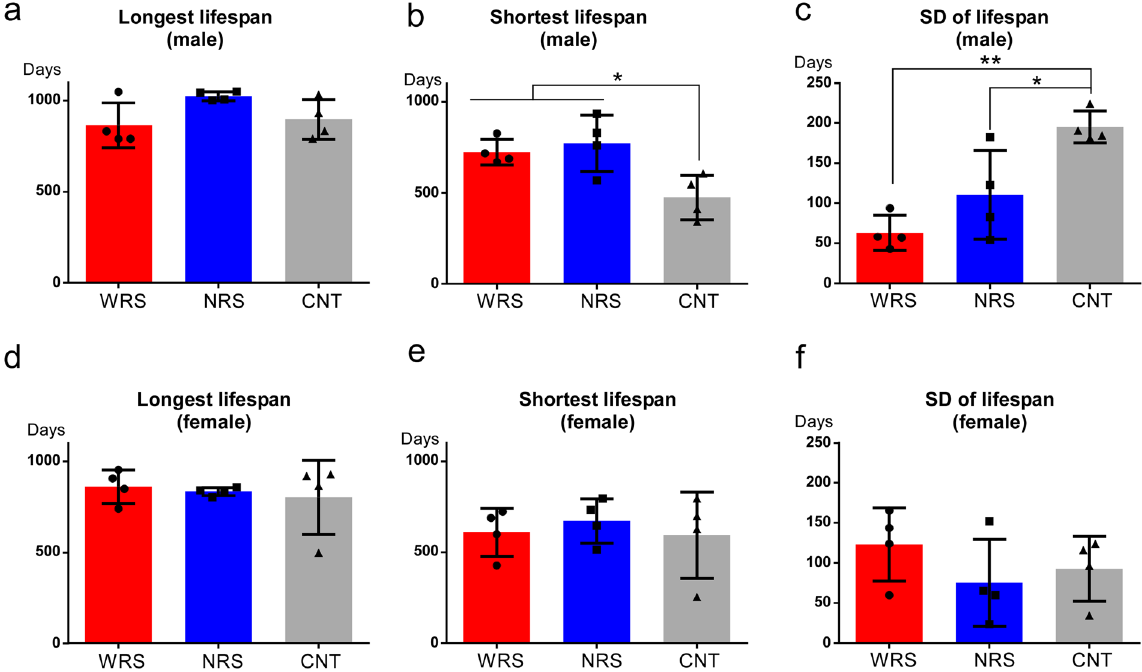
Figure 4. Individual differences in lifespan of each cage for all sound conditions: WRS (wide range of sounds), NRS (narrow range of sounds), and CNT (control). Longest lifespans of ( a ) males and ( d ) females. Shortest lifespans of ( b ) males and ( e ) females. Standard deviation (SD) of lifespans of ( c ) males and ( f ) females. ANOVAs of the longest lifespan, shortest lifespan, and SD of lifespan were conducted using representative values for each cage calculated on the basis of individual lifespans. Error bars indicate the standard